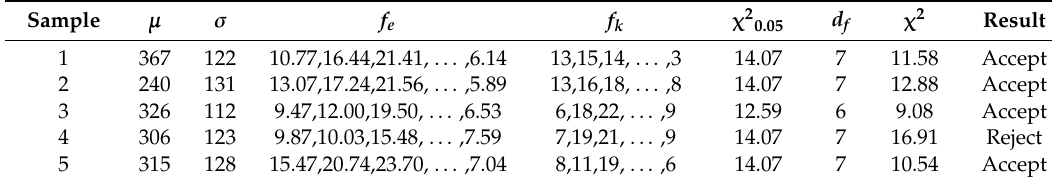
Figure 6. Statistical test of 370 sampled distributions. Table 1. Examples of the goodness-of-fit test for some samples.